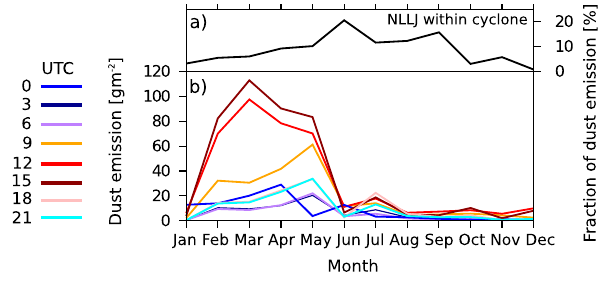
Figure 15. Total dust emission amount associated with long-lived and migrating cyclones. Annual cycle of (a) the fraction of dust emission associated with cyclones and NLLJs and (b) the total dust emission associated with cyclones at different times of the day (colours). Values are spatially integrated over the northern sub- domain (15 ◦ W–40 ◦ E and 20–40 ◦ N) and monthly averaged over 1989–2008. NLLJ events are identified as in Fiedler et al. (2013).